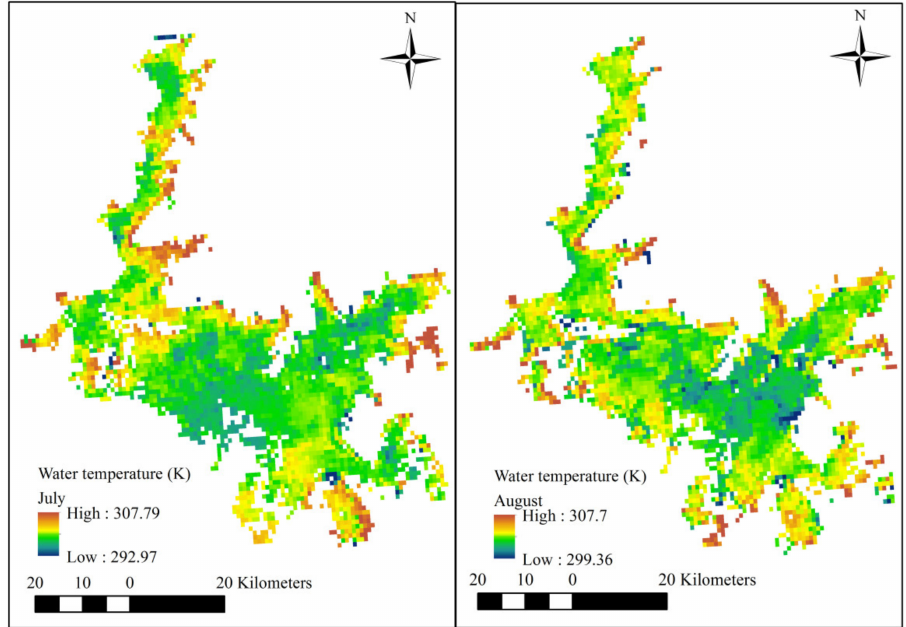
Figure 2. The Poyang Lake boundary obtained using satellite-derived lake water surface tempera- tures in July and